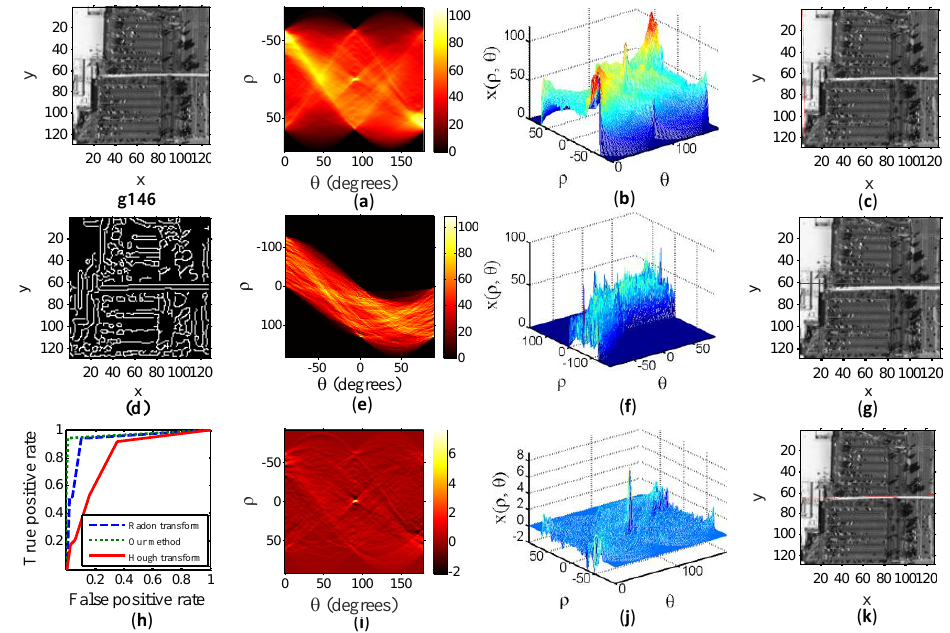
( f ). ( h ) Receiver Operator Curves of the evaluated detection methods. ( i ) Transform image obtained by our method. ( j ) Three-dimensional form of ( i ). ( k ) Detected line from ( j ).